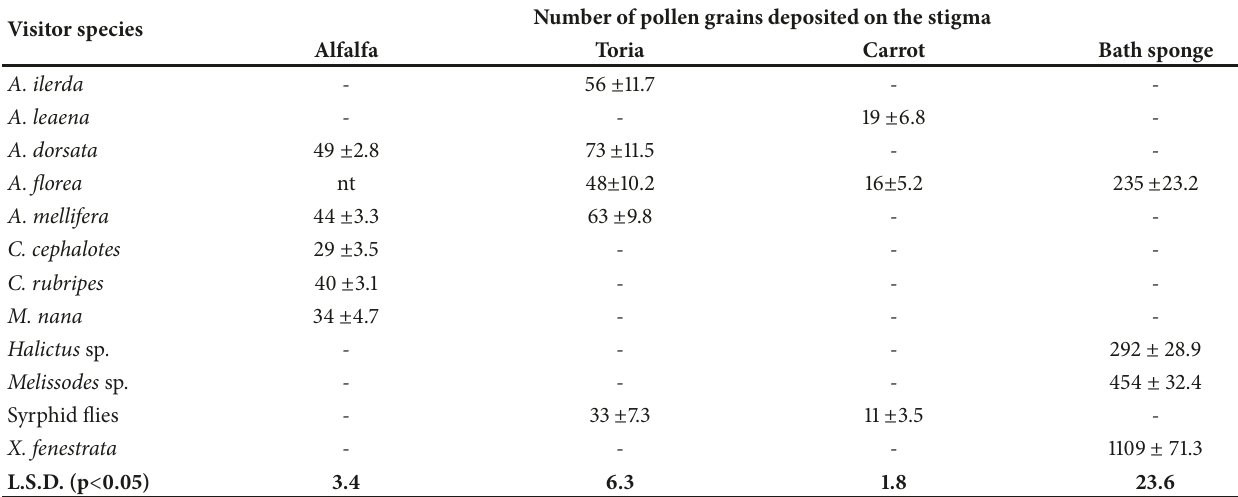
Table 2: Number of pollen grains deposited by the visitors on the stigmas of different plant species. Visitor species